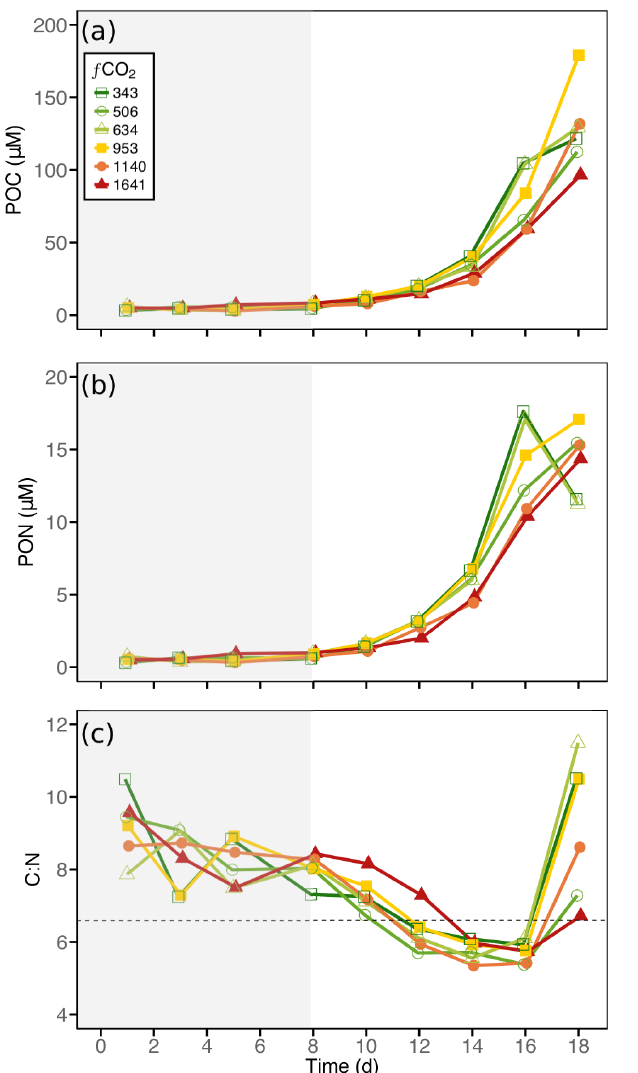
Figure 5. Phytoplankton biomass accumulation and community pri- mary production in each of the minicosm treatments over time. (a) Chlorophyll a (Chl a ) concentration, (b) 14 C-derived gross pri- ), and (c) O 2 -derived gross community mary production (GPP 14 C production (GCP O ). Grey shading indicates CO 2 and light accli- 2 mation